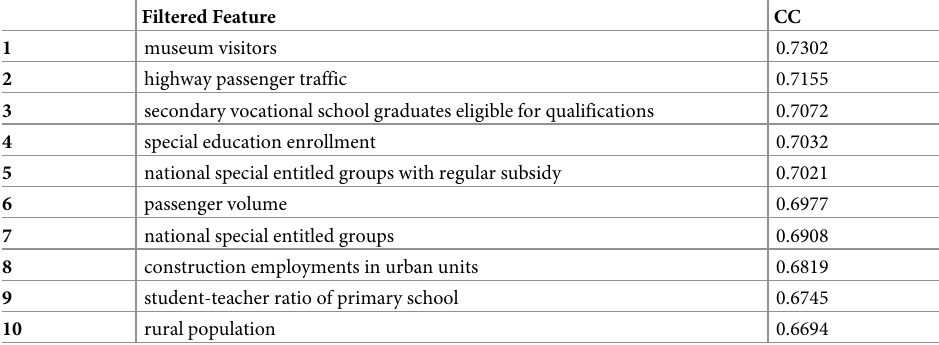
Table 2. Top 10 high scoring features for CC